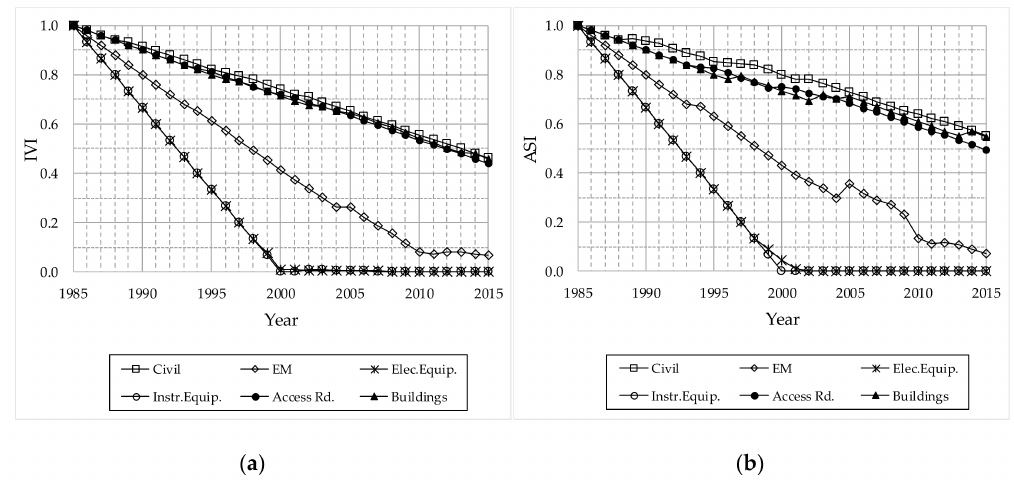
Figure 3. Element condition assessment of Asset 1: ( a ) Infrastructure Value Index (IVI) index; ( b ) Asset Sustainability Index (ASI)